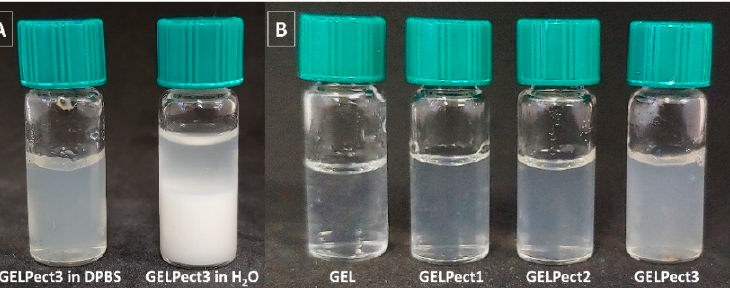
Figure 1. Representative picture of GELPect3 in DPBS and ultrapure water ( A ) and picture of GELPect slurries with different gelatin to pectin ratios in DPBS ( B ).